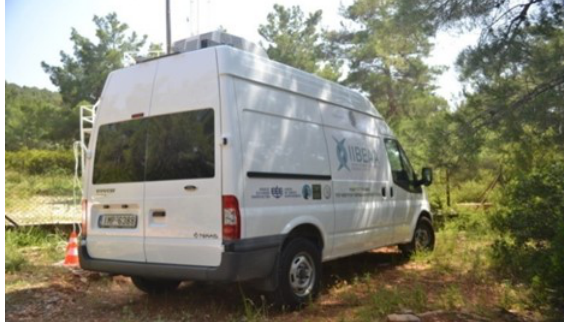
Table 1 . Technical characteristics of the optical components of the wavelength separation system of EOLE.